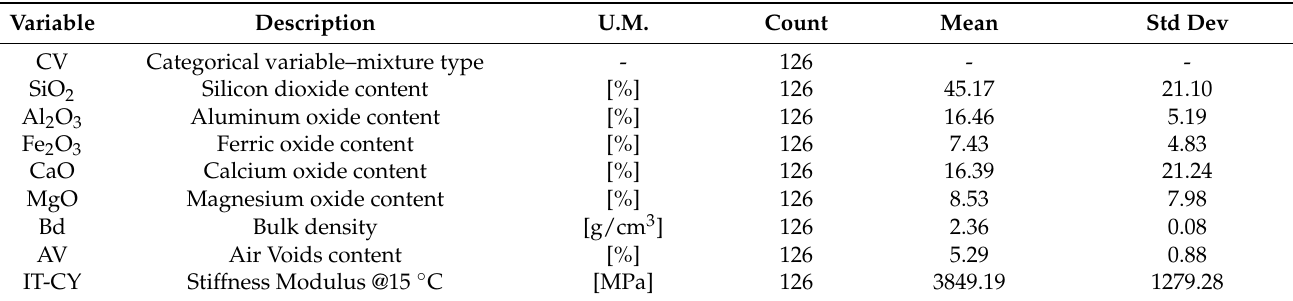
Table 3. Statistical description of CatBoost model